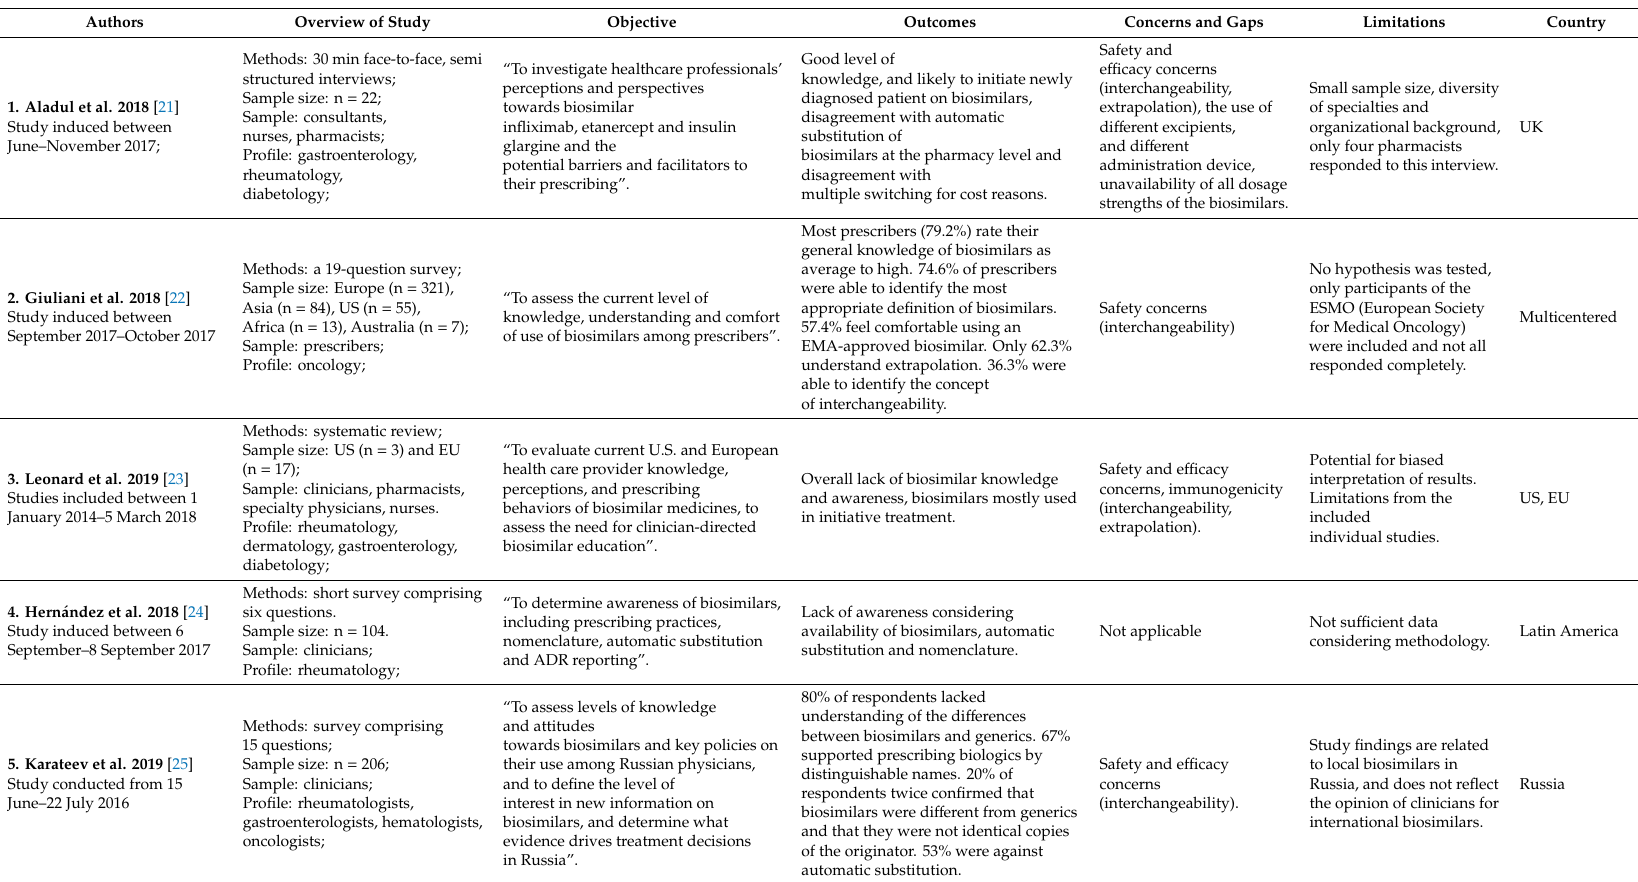
Table 2. Overview of studies included in the